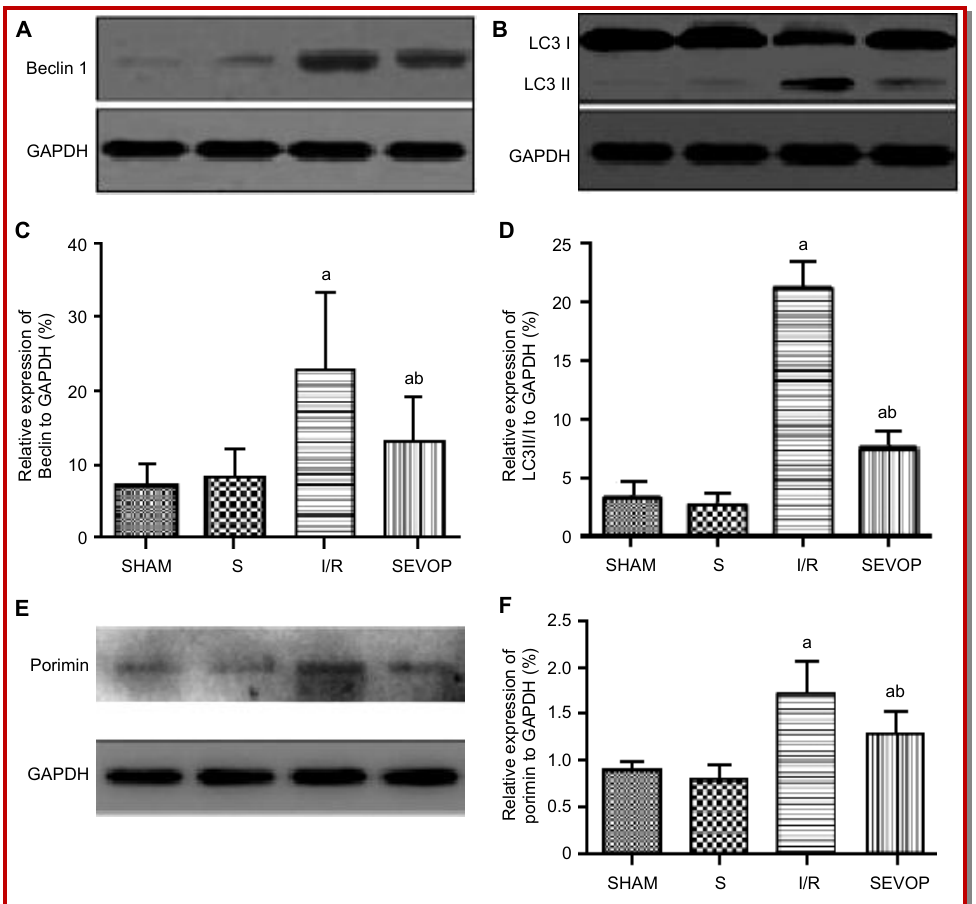
Figure 3: Western blotting results and quantitative analysis of Beclin-1, LC3II/I, and Porimin protein expression in rat hearts in the Sham, S, I/R, and SEVOP groups (A) Western blotting results of Beclin-1 protein expression in rat hearts of the 4 groups. (B) Western blotting results of LC3II/I protein expression in rat hearts of the 4 groups. (C) Quantitative analysis of the Western blotting results of Beclin-1 protein expression in rat hearts of the 4 groups. (D) Quantitative analysis of the Western blotting results of LC3II/I protein expression in rat hearts of the 4 groups. After one-way analysis of vari- ance, the Student-Newman-Keels method was used to compare the mean values among multiple samples. The results were presented as the mean ± standard deviation. Compared to the Sham group, a p<0.05; compared to the I/R group, b p<0.05. p<0.05 indicated statistical significance. Sham: Sham surgery group; S: Sevoflurane group; I/R: Ischemia-reperfusion group; SEVOP: Sevoflurane postconditioning in the myocardial ische- mia-reperfusion